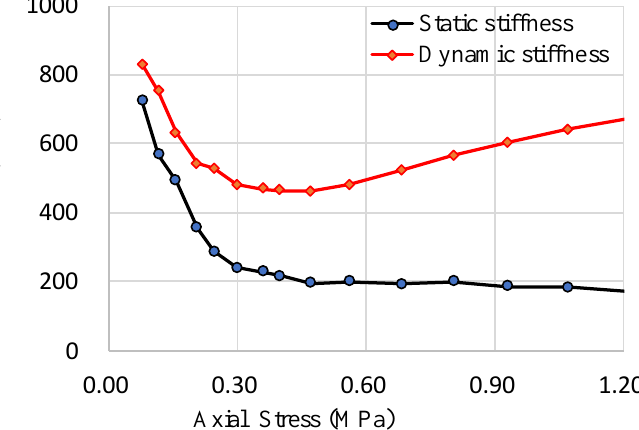
Figure 5. The relationship between the static and dynamic stiffness of the silicone rubber strip and the load mass.